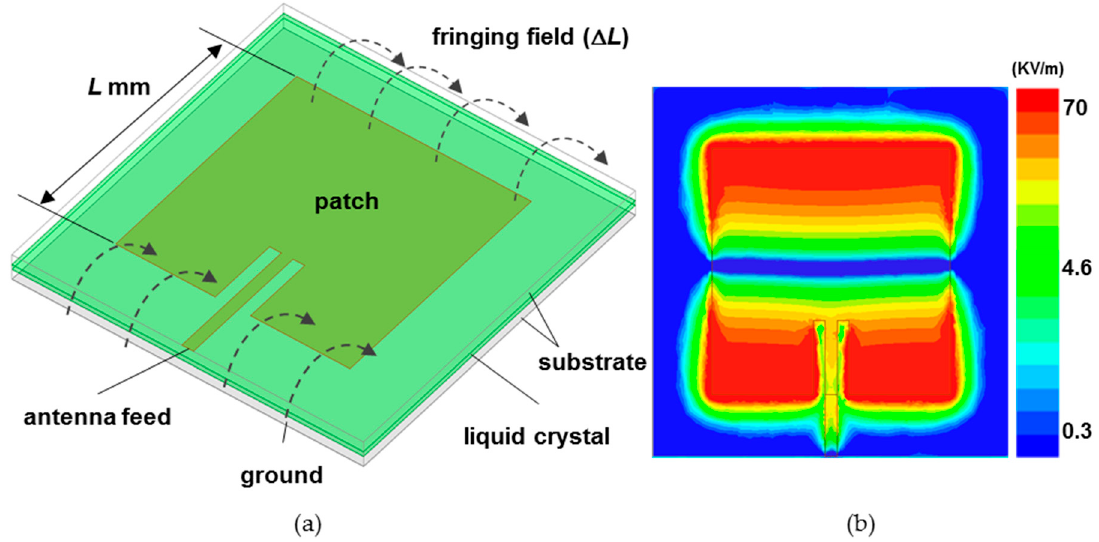
Figure 1. ( a ) Schematic diagram of a tunable liquid crystal patch antenna and ( b ) electric-field distribution on a patch antenna surface. Here, L and ∆ L refer to the patch length and fringing field length, respectively.